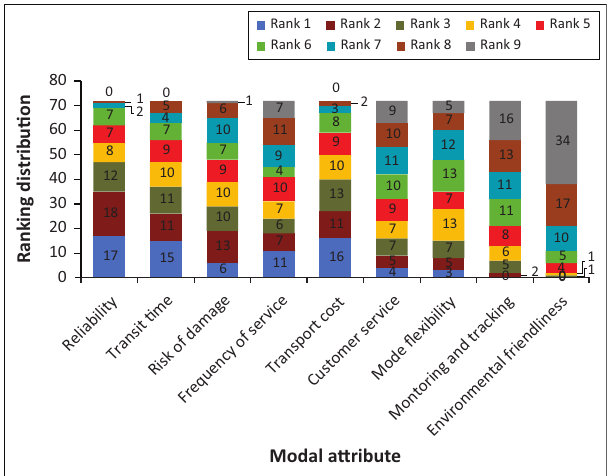
FIGURE 2: Summary of rankings for modal attributes.